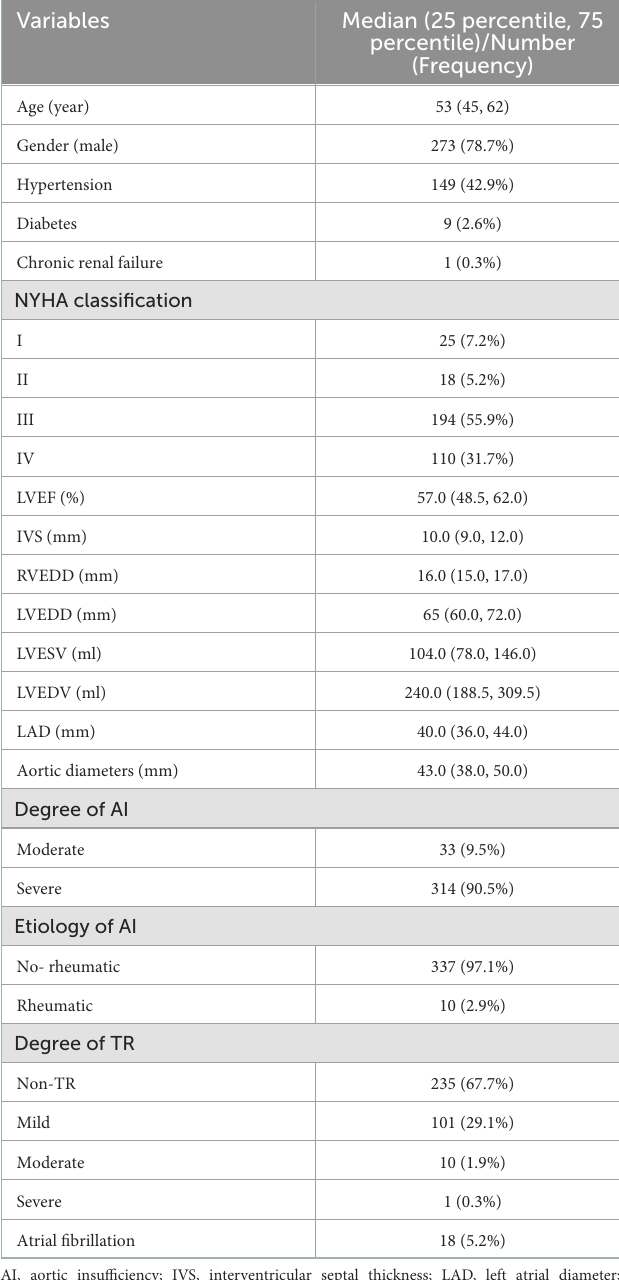
TABLE 1 Baseline characteristics and preoperative echocardiography.